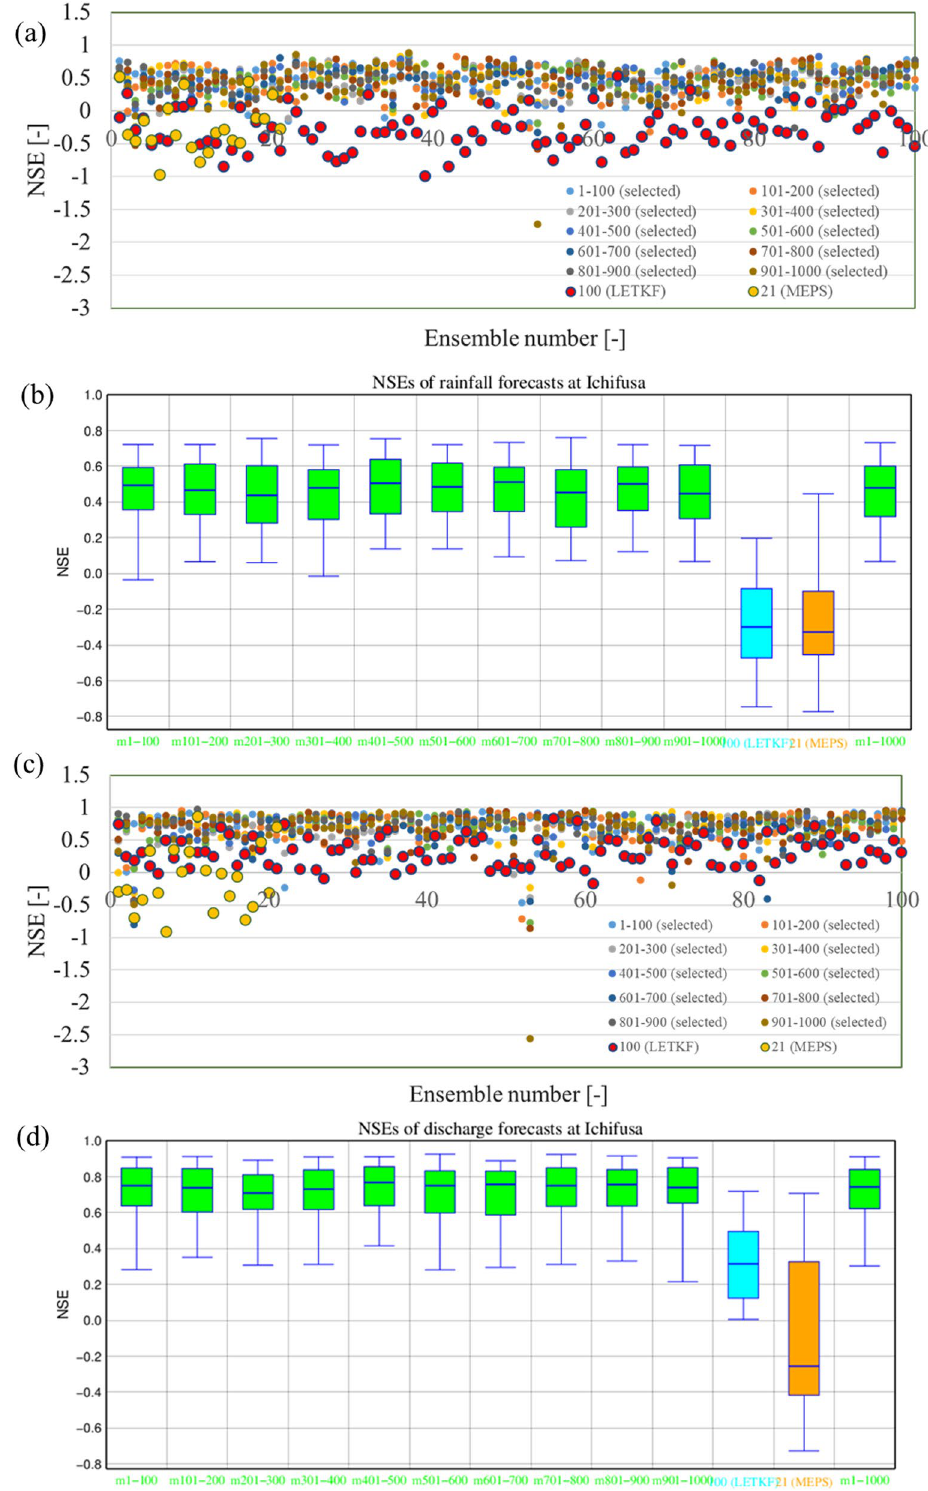
Fig. 11 a NSEs of rainfall, b NSE box plots of rainfall, c NSEs of discharge and d NSE box plots of discharge for Ichifusa